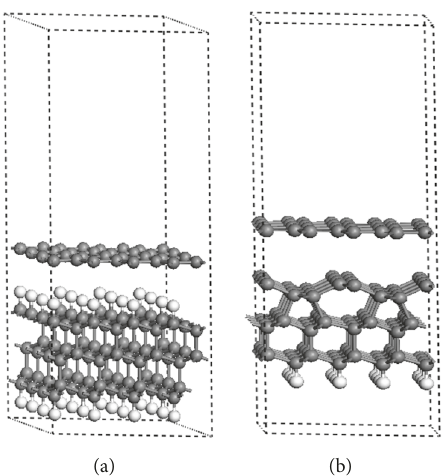
Figure 1: Side viewof grapheneon topof a (a)H-terminateddiamond (111) surface,and on topof (b) anonterminatedreconstructeddiamond (111)-2 × 1 surface. The H and C atoms are shown in white and gray colour,